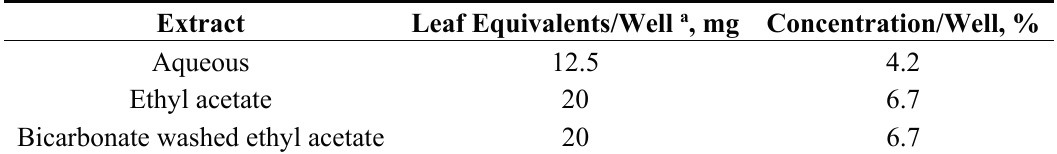
Table 1. Neem leaf extracts used in Bioscreen treatments.